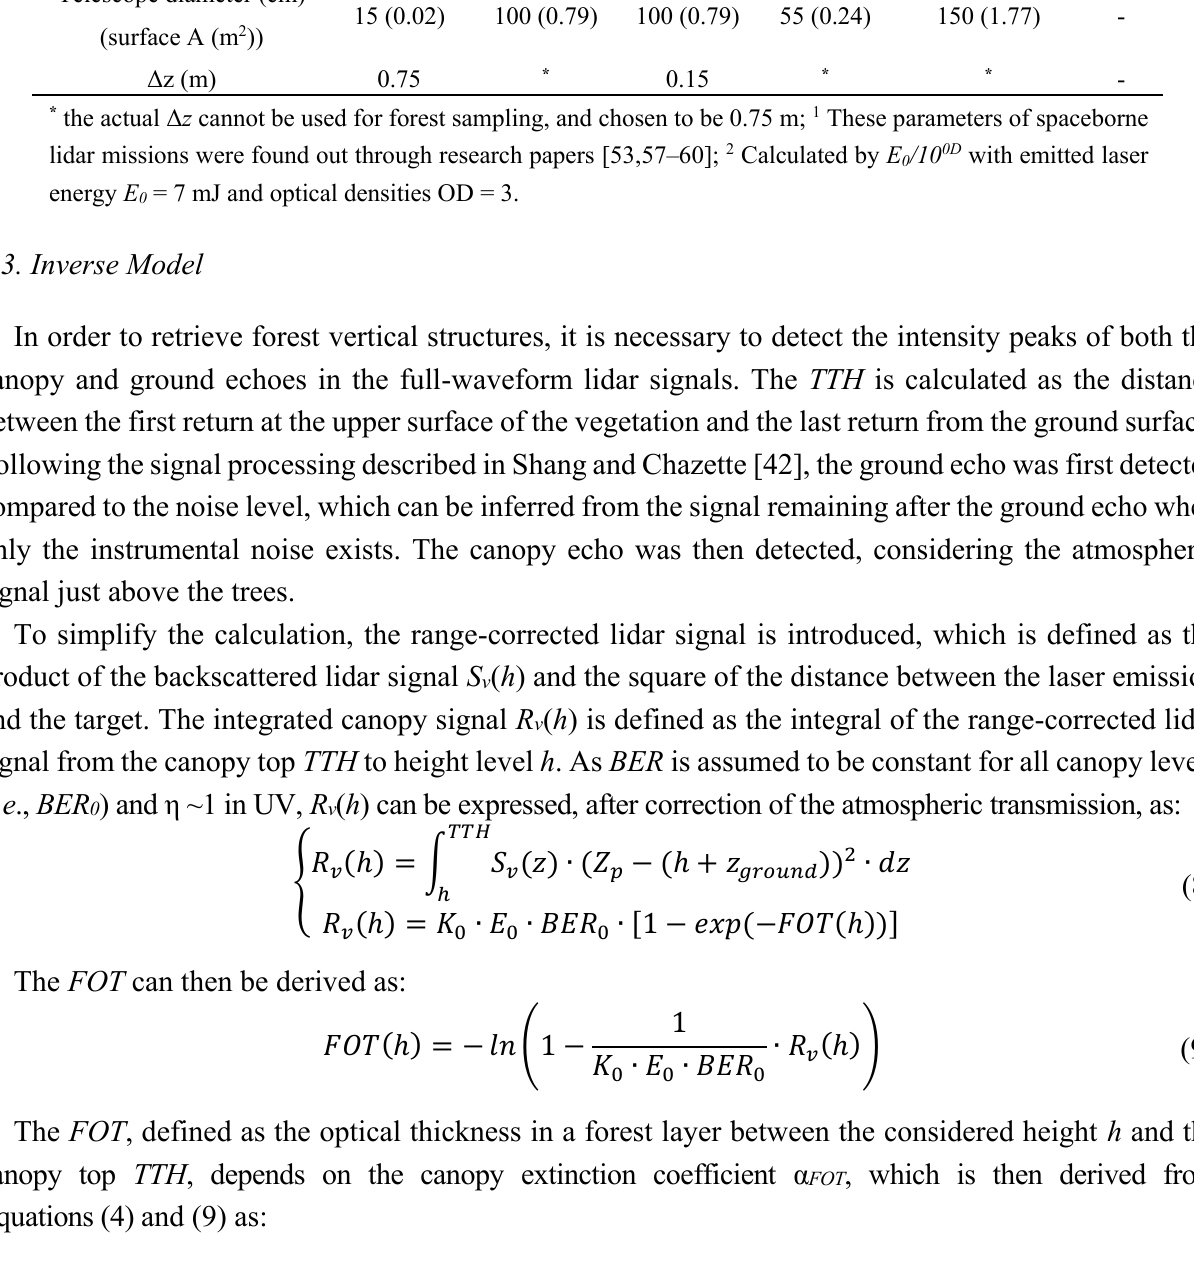
Telescope diameter (cm) (surface A (m 2